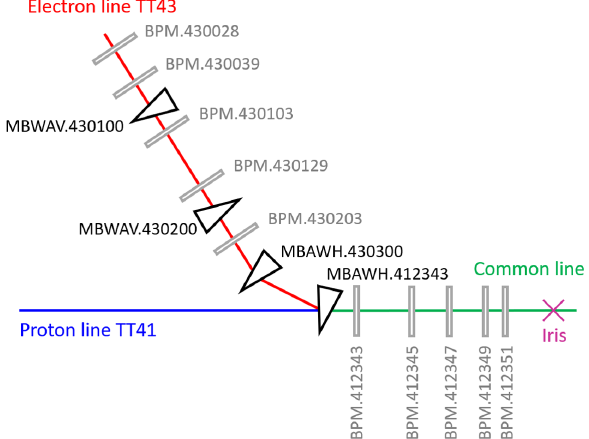
FIG. 11. Schematic of the proton beamline (blue), electron beamline (red), and common line (green). The relevant BPMs are shown as rectangles and the electron line dipoles as triangles; quadrupoles are not shown in this diagram. The beams propagate from left to right. The iris marker highlights the start of the